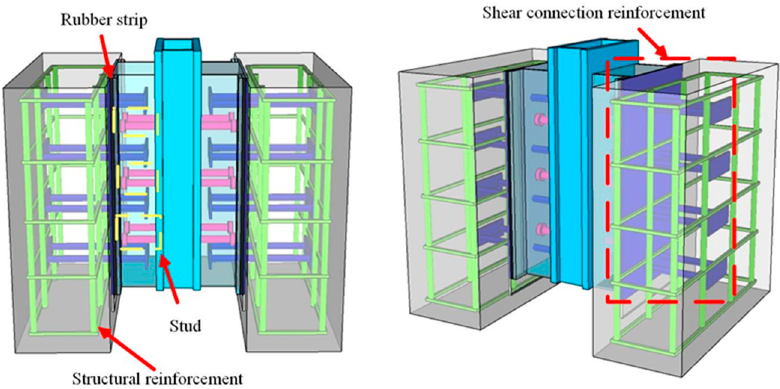
Figure 4. Three-dimensional of the specimen.